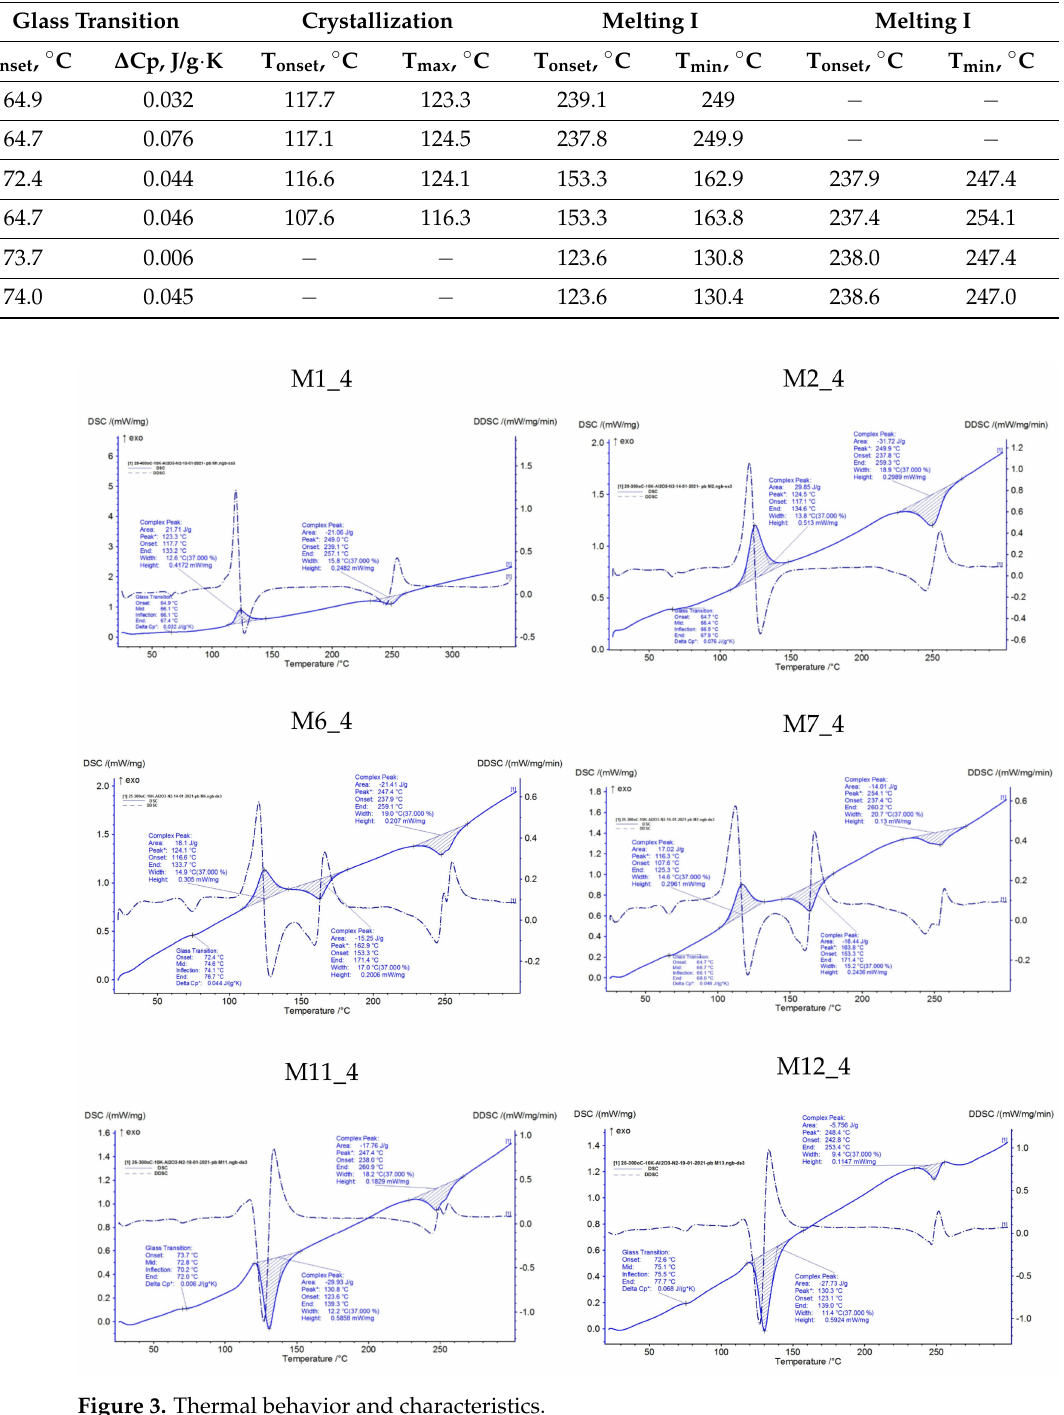
Figure 3. Thermal behavior and